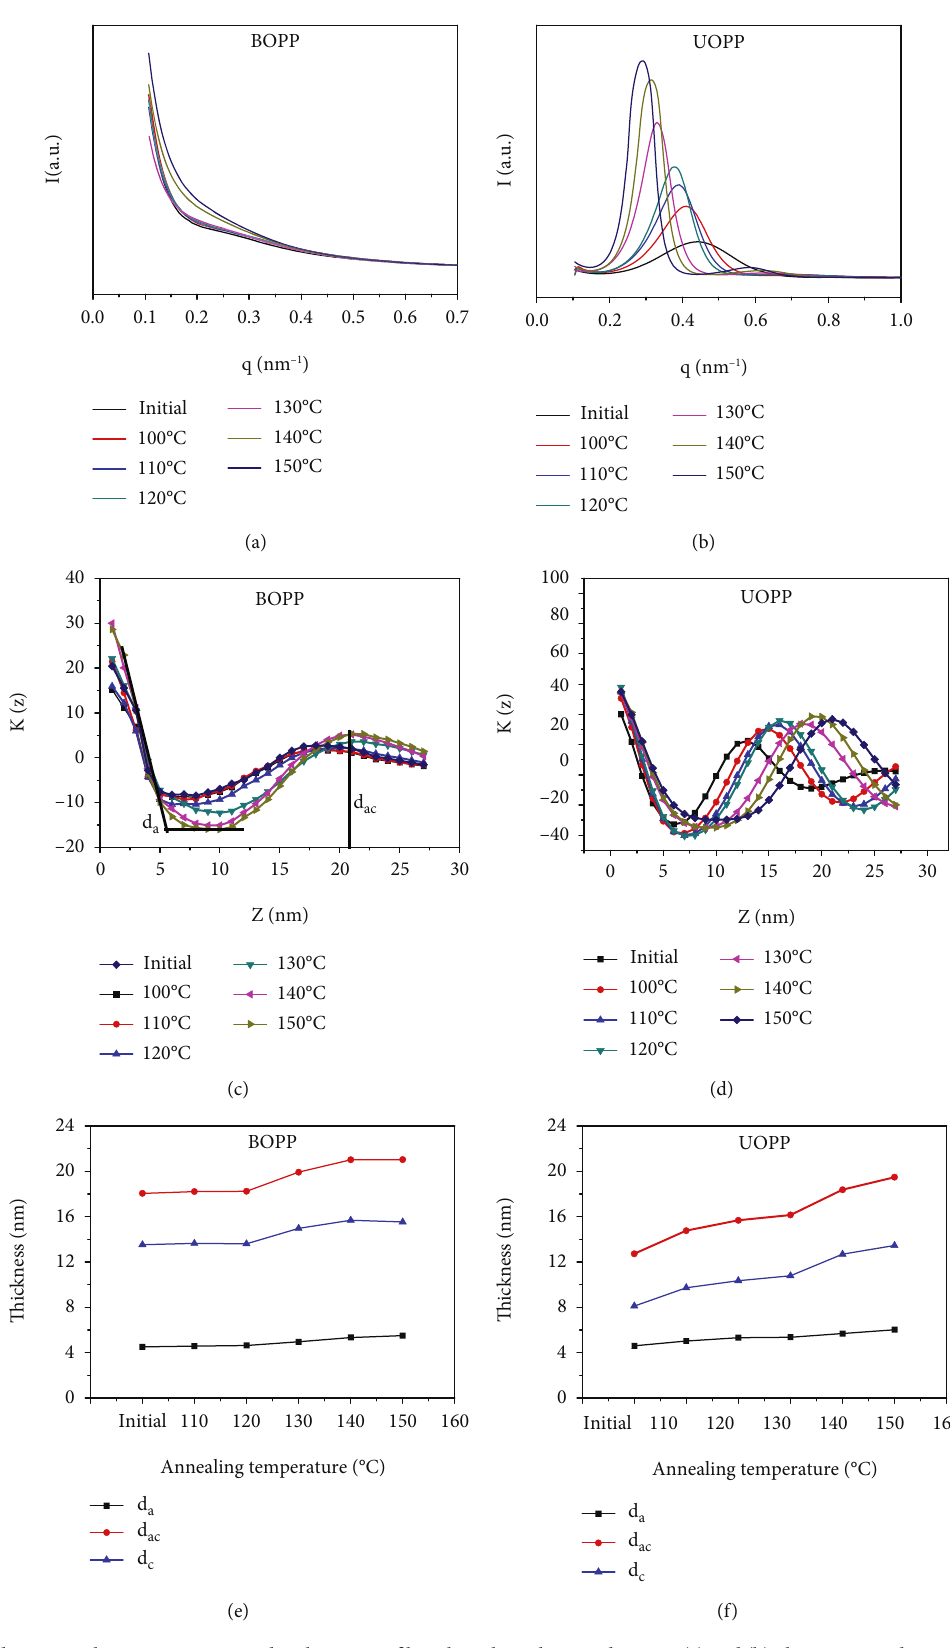
Figure 6: One-dimensional scattering intensity distribution pro fi les taken along the MD direction (a) and (b), the corresponding correlation functions (c) and (d), long periodicity, lamellar thickness, and the average thickness of the amorphous layer (e) and (f) at di ff erent annealing